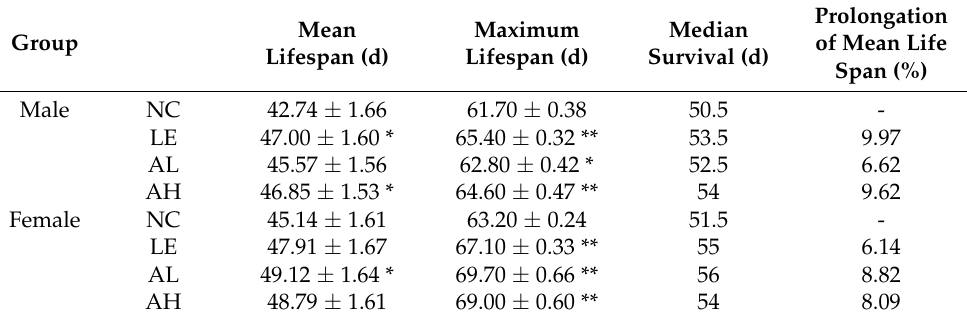
Table 1. Effects of Agrocybe aegerita polysaccharide on the lifespan of Drosophila .